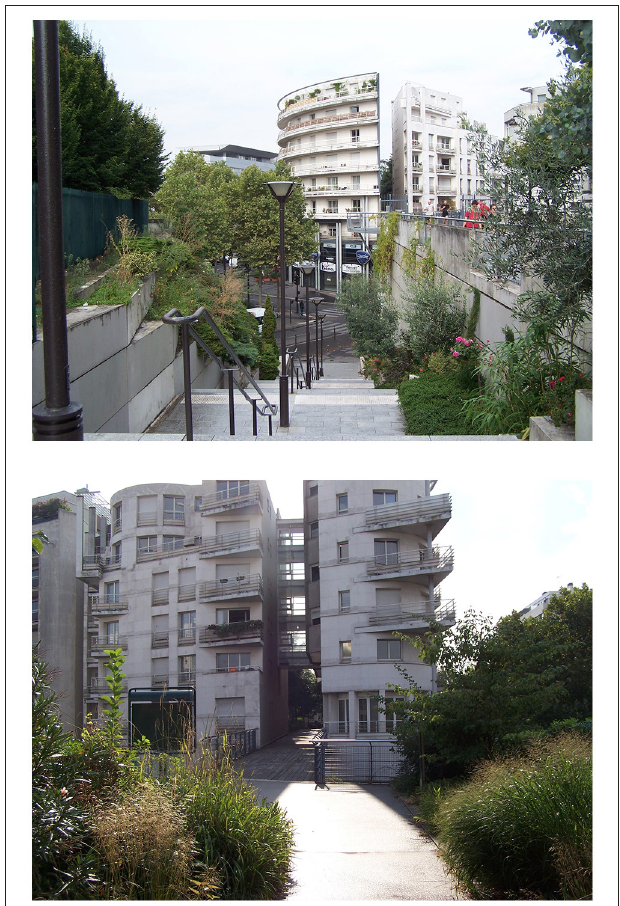
FIGURE 2 | Promenade Plantée, Paris.